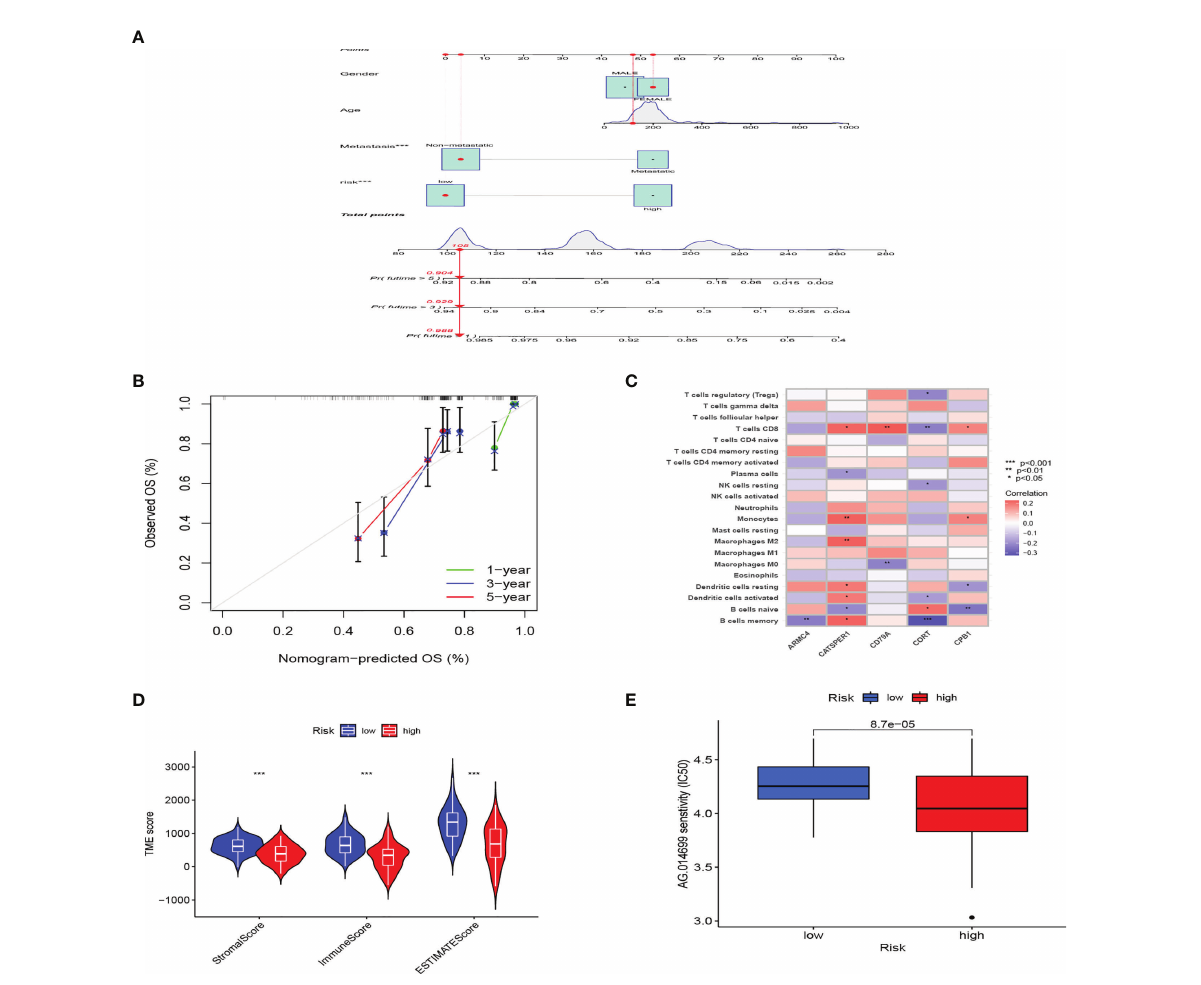
FIGURE 5 The clinical application value of PRG_score and evaluation of the TME of different subgroups. (A) In the training group, nomogram for predicting the 1-, 3-, and 5-year survival of OS patients. (B) In the training group, calibration curves of the nomogram for predicting of 1-, 3-, and 5-year overall survival. (C) Correlation analysis among the tumor in fi ltrations of immune cells and fi ve genes in the risk model. (D) Correlations between PRG_score and TME scores. (***:p value <0.001). (E) PRG score and chemotherapeutic sensitivity relationships. PRG, pyroptosis-related gene; TME, tumor microenvironment; OS,